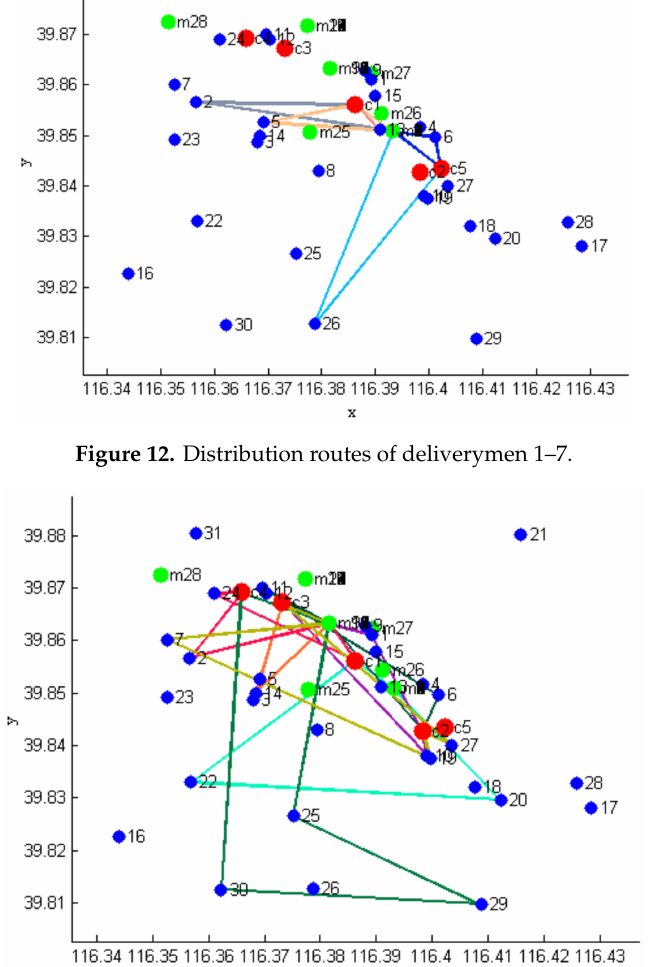
Figure 13. Distribution routes of deliverymen